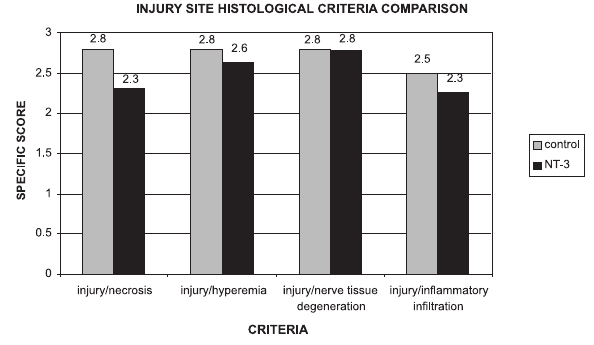
Figure 4 - Comparison of Specific Scores in the Injury Site between Control and NT-3 Groups